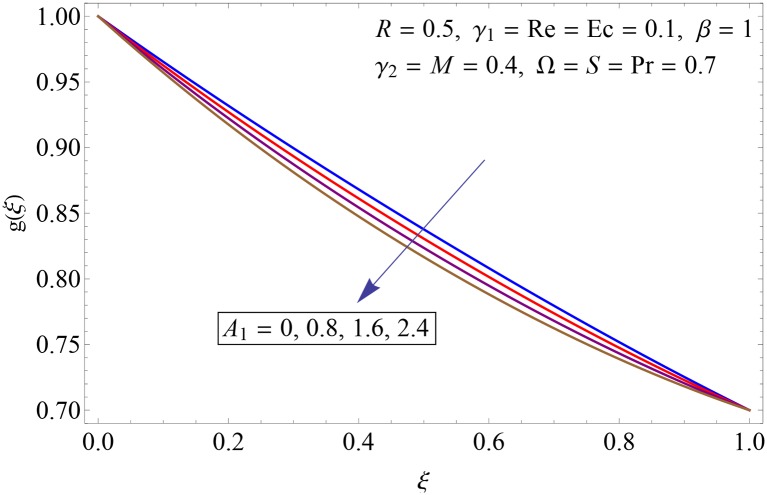
Impact of A1 on g(ξ).